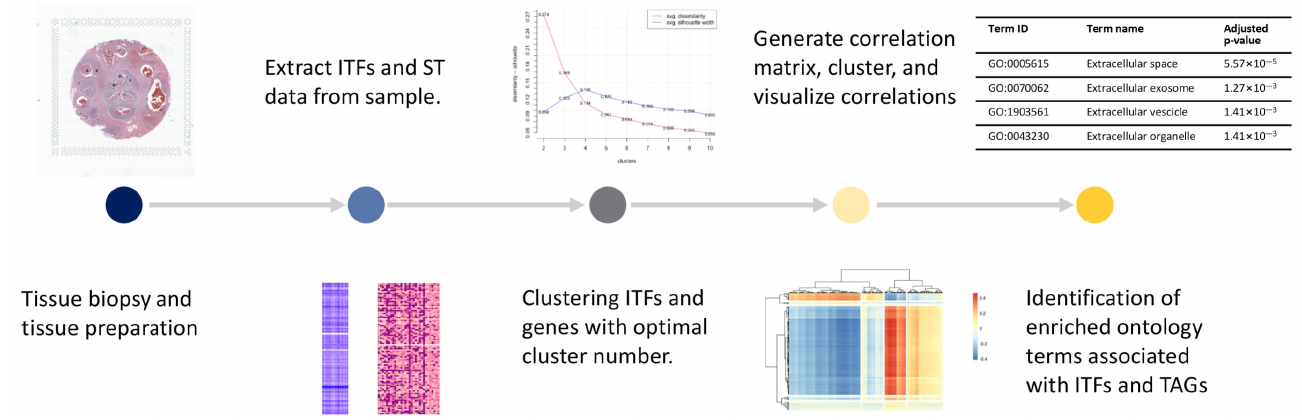
Tissue biopsy and tissue preparation